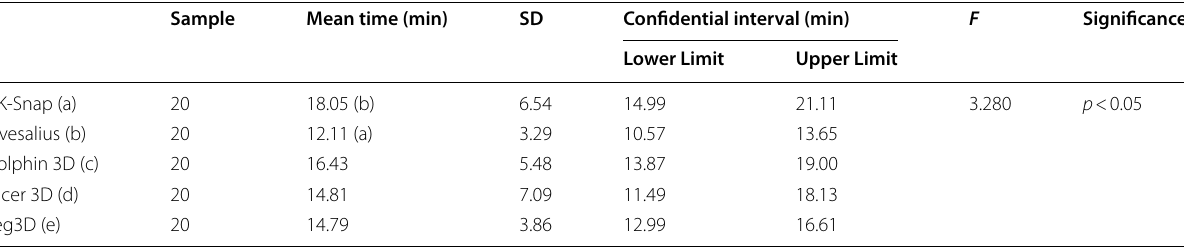
Table 4 Comparison of the image processing time for upper airway segmentation